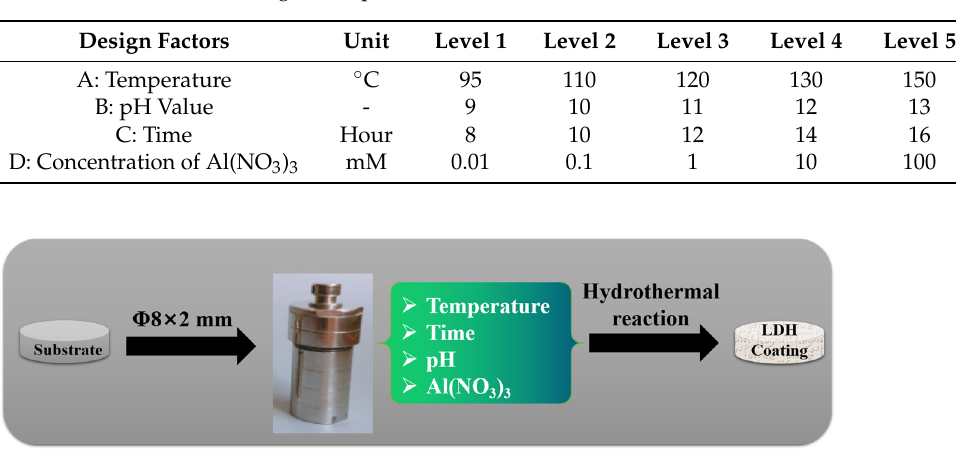
Table 1. Factor level in orthogonal experiments.